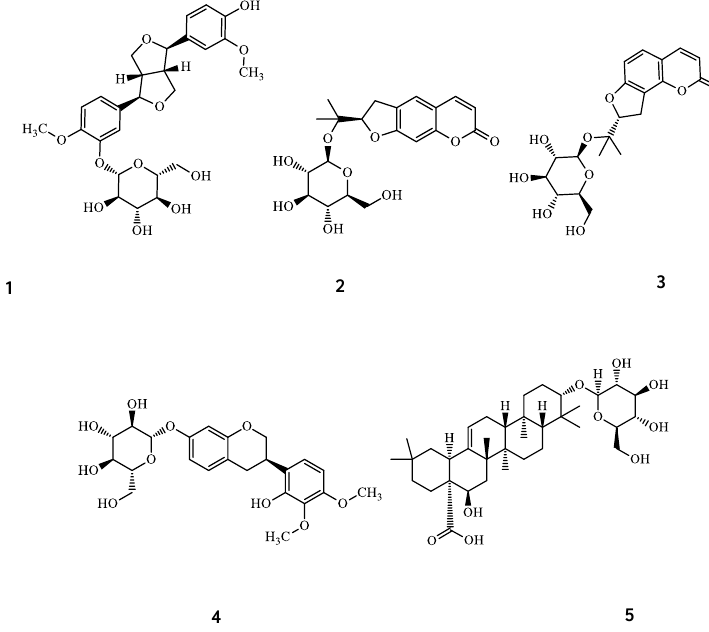
Figure 2. Chemical structures of compounds isolated from RPH. RPH (1.5 kg) was fractioned using various organic chemicals and columns as described in “Materials and Methods”. Finally, five single components were identified from RPH, and then structure of each component was analyzed using ESI-MS, 1 H-NMR, and 13 C-NMR spectrum. Inhibitory effects of each fraction identified from organic chemicals were determined in the expression of MMP13 (data not shown). Structures of ( 1 ), ( 2 ), ( 3 ), ( 4 ), or ( 5 ) indicate ( − )-pinoresinol 4- O - β - D -glucopyranoside, ( − )-marmesinin, columbianetin β - D -glucopyranoside, isomucronulatol 7- O - β - D -glucoside (IMG) and ecliptasaponin A (ES),